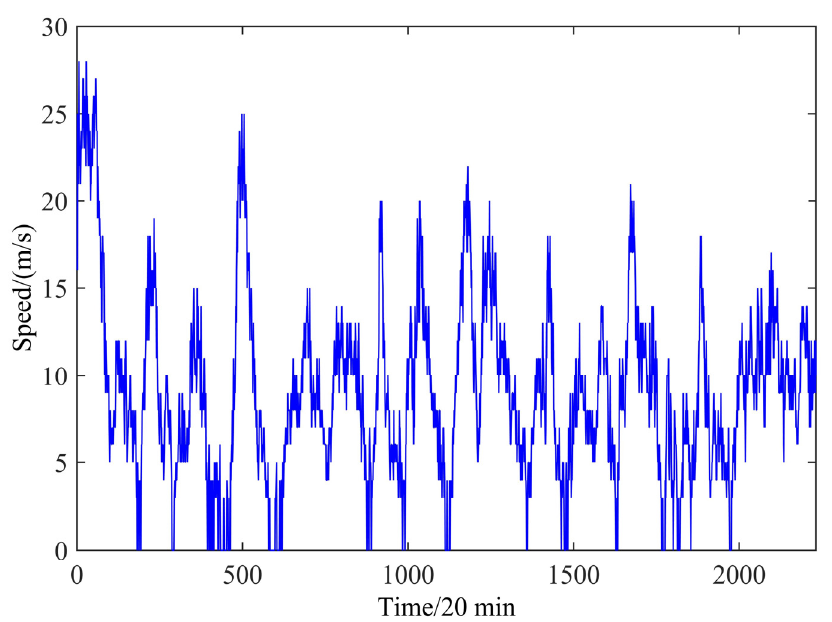
Figure 3. Wind speed during the period from 1 January to 31 January